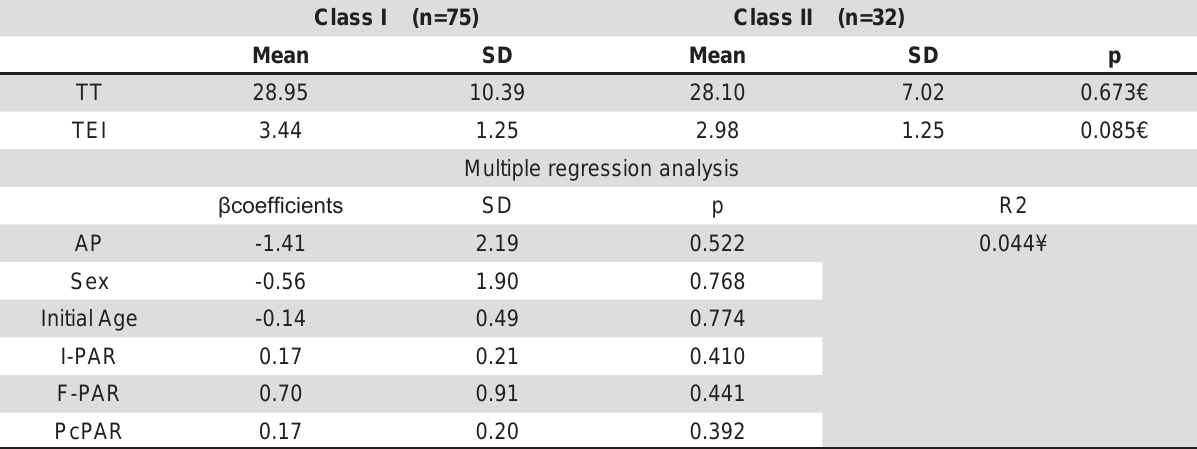
Table 4- Comparison of Class I and complete Class II malocclusion groups regarding treatment time (TT - in months) and